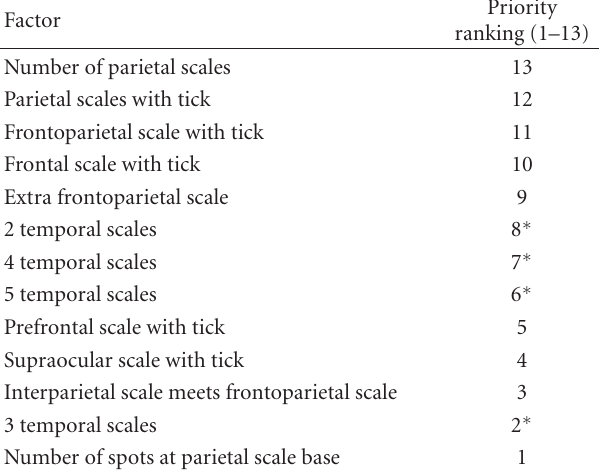
Table 2: List of factors used to distinguish turtles in the developed keys. Priority indicates a ranking system from 1 to 13, where 13 in- dicates the most obvious characteristic to separate individuals, this ranking was used as a weighting factor in the development of the priority key. ∗ For the combined key all these factors were weighted as